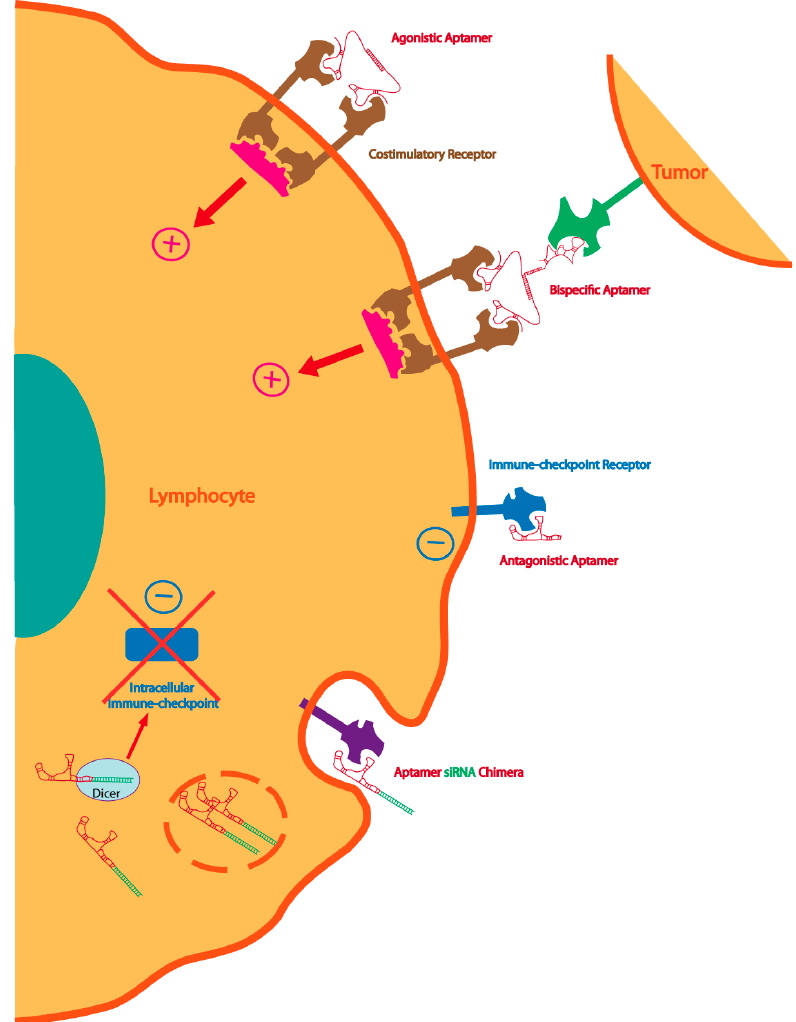
Figure 2. Multiple strategies to enhance immunity with aptamers: dimeric or multimeric aptamers against co-stimulatory receptors can be used as agonistic molecules of the cognate receptor. The same agonistic aptamer can be delivered to the tumor, improving the therapeutic index, by coupling with a tumor-specific aptamer. Immune-checkpoint blockade aptamers against cell-surface receptors can be used to enhance tumor immunity. The blockade of the intracellular immune-checkpoint that orchestrates an immune suppression pathway can be inhibited by targeting aptamer-siRNA chimeras to the lymphocyte or the tumor cell.